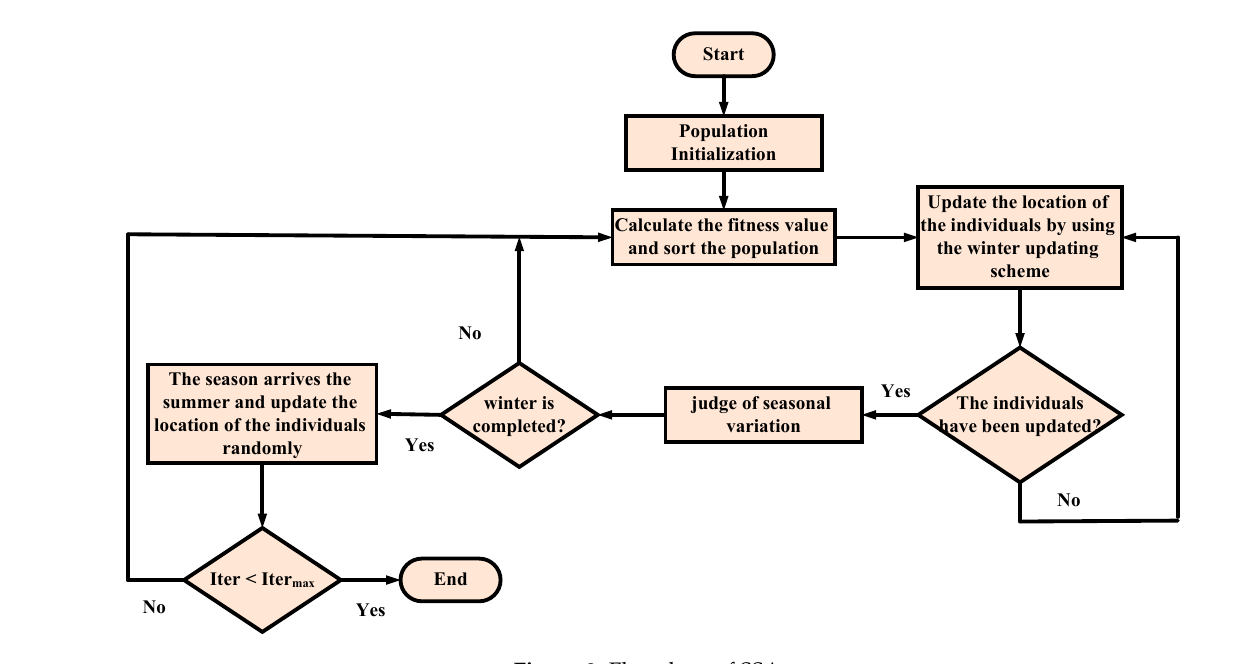
Table 1. The values of optimal parameters of considered controllers using SSA.